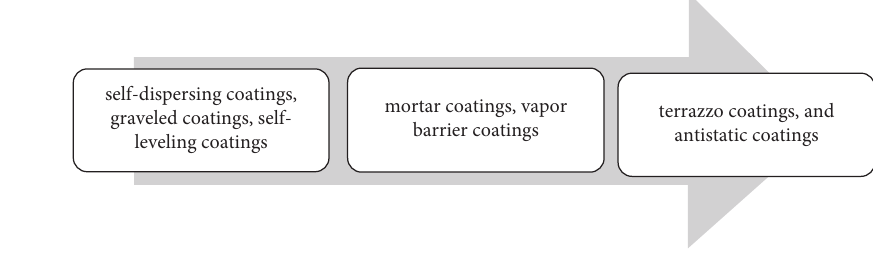
Figure 1: Types of epoxy floor coatings.